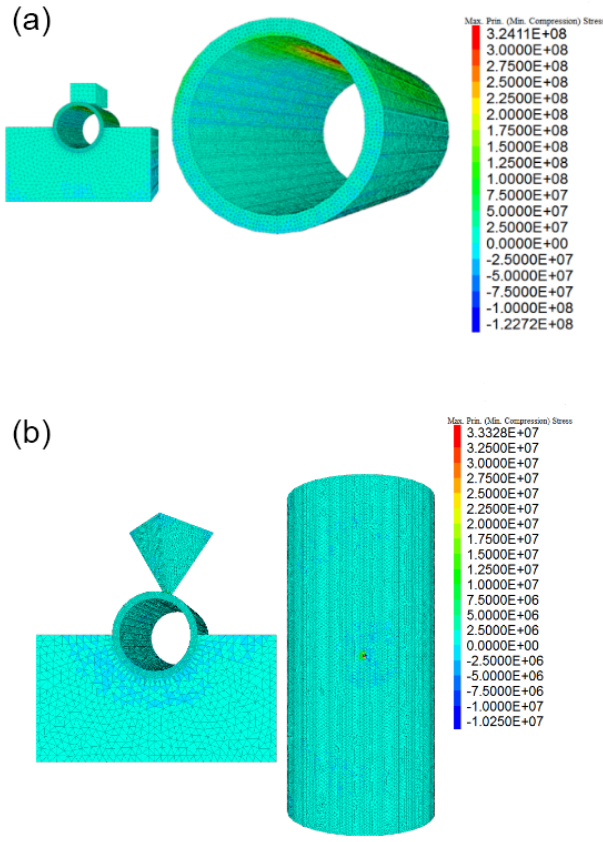
Figure 14. (a) Maximum principle stress [Pa] (pure elastic). (b) Maximum principle stress [Pa] (dynamic point